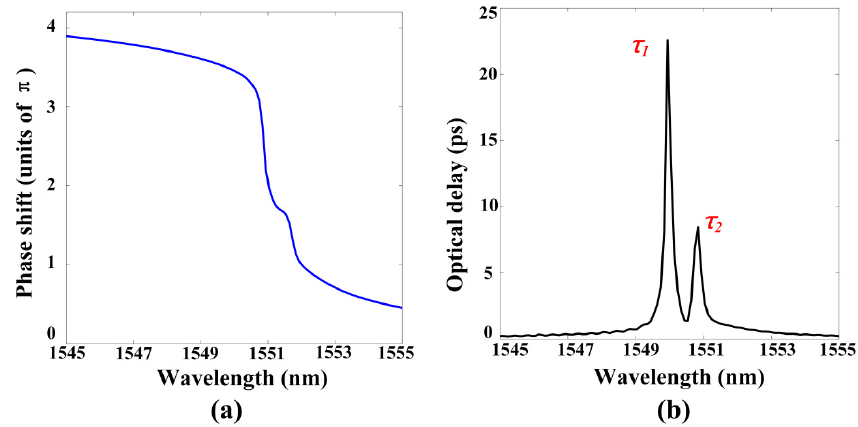
Figure 3. ( a ) The spectrum of phase shift in the GMR system with the double EIT-like e ff ect in Figure 1; ( b ) The spectrum of delay time in the GMR system with the double EIT-like e ff ect in Figure 1. Table 1. Delay time compared to other slow light works based on grating and the GMR e ff ect.